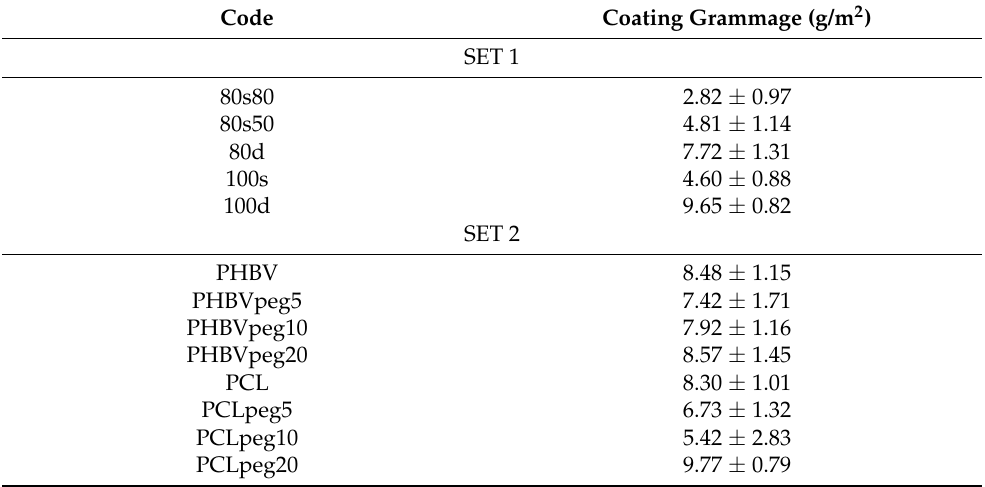
Table 2. Coating